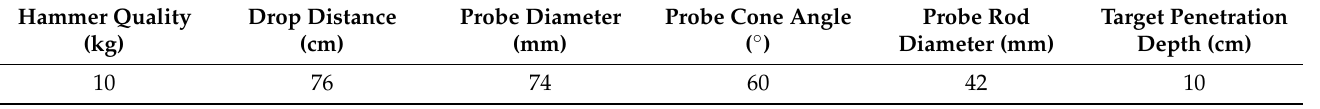
Table 2. Heavy-duty dynamic penetration parameters.